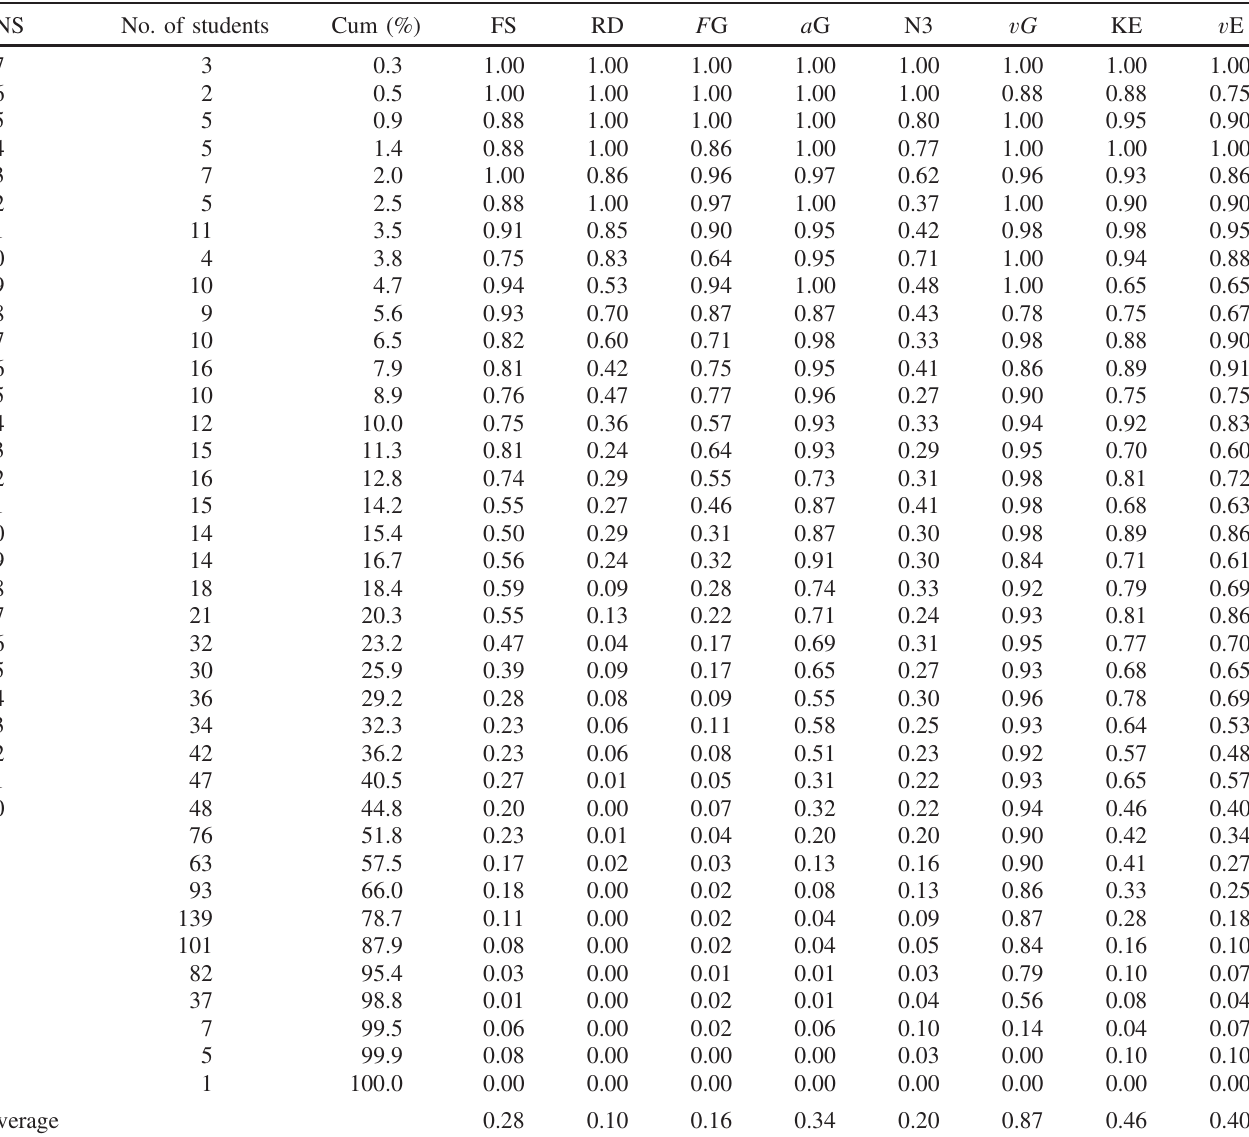
TABLE IV. Average difficulty index in clusters in terms of SNS. SNS No. of